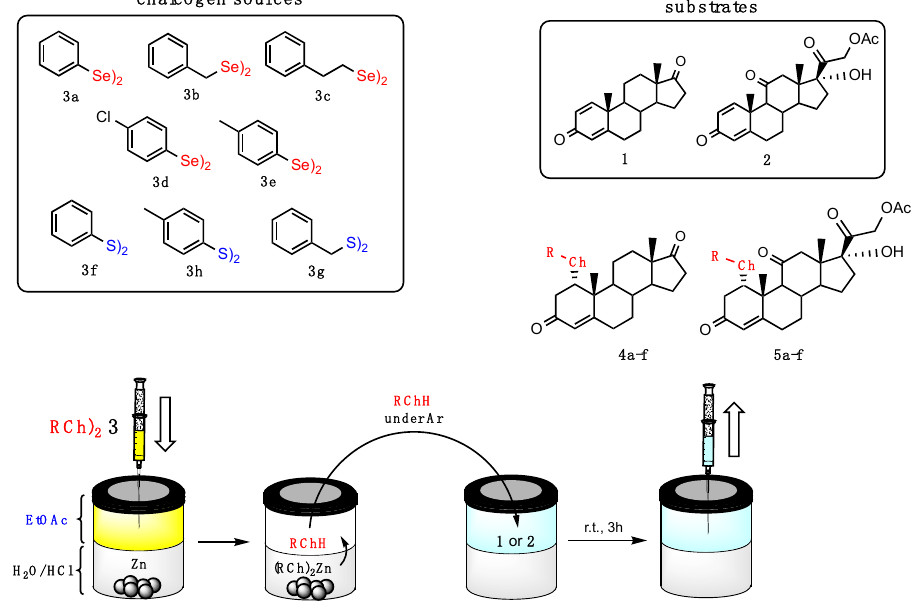
Figure 2. Addition reaction of nucleophilic reagents prepared in situ from the dichalcogenides 3a – g to the Michael acceptors 1 and 2 affording the target compounds 4a – f and 5a – g, respectively (the scopes are reported in Tables 1–3).